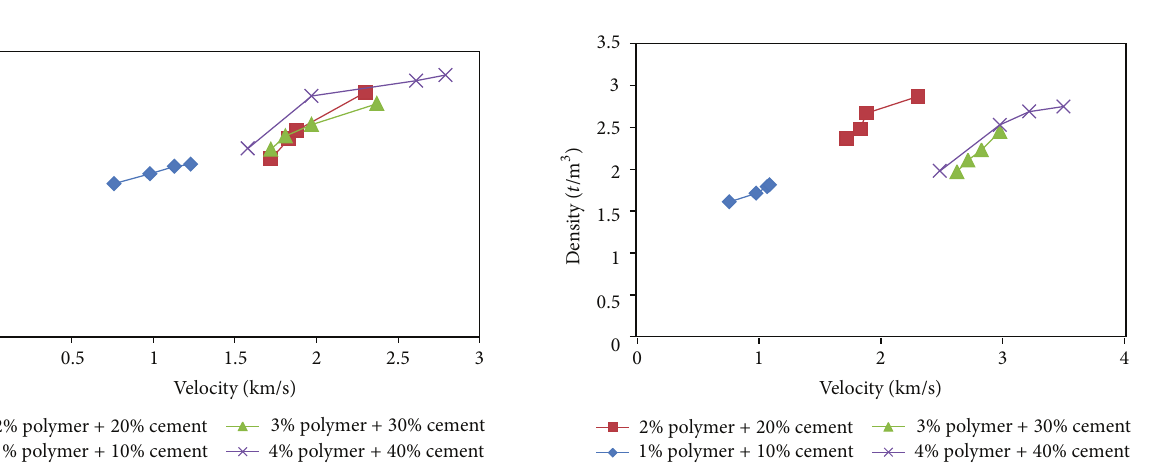
Figure19:Ultrasonicpulsevelocitytestprocedureinwetconditions for 14